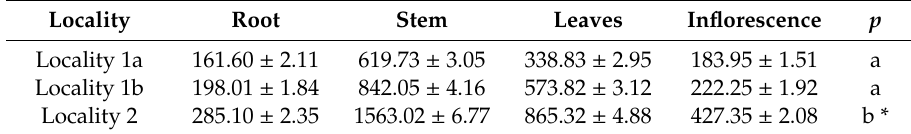
Table 3. Antioxidant activity of the di ff erent parts of I. helenium (IC 50 , µ g / ml).